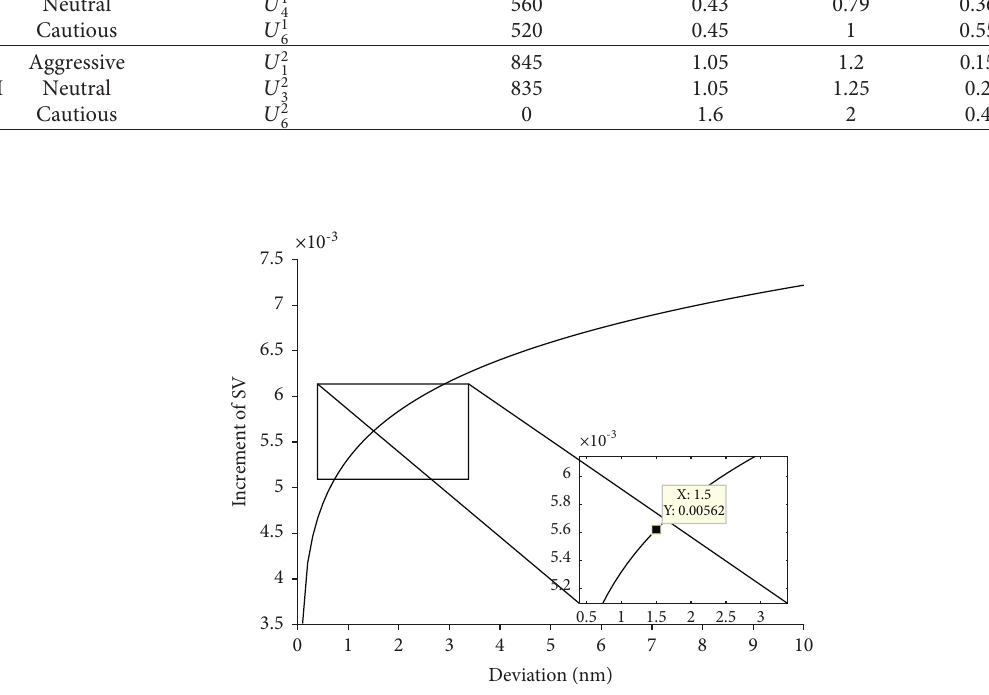
Figure 13: The fitness between the deviation and the increment of the SV. (5) The relationships between cost (i.e., deviation) and profit (i.e., SV) are not linear. By simulating 100 cases of increasing the deviation from 0.1 nm